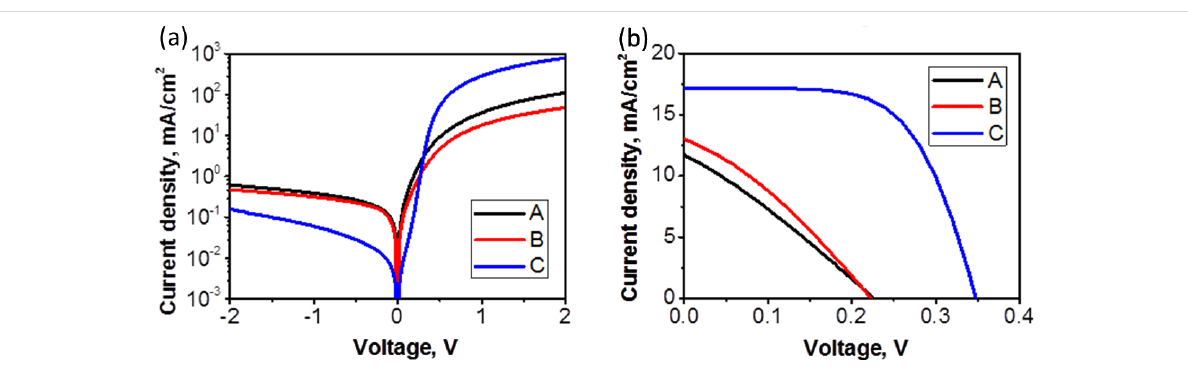
Figure 3: Current–voltage characteristics for the ZnO:Al/ZnO NR /Si/Al heterostructures measured under dark (top) and under light conditions